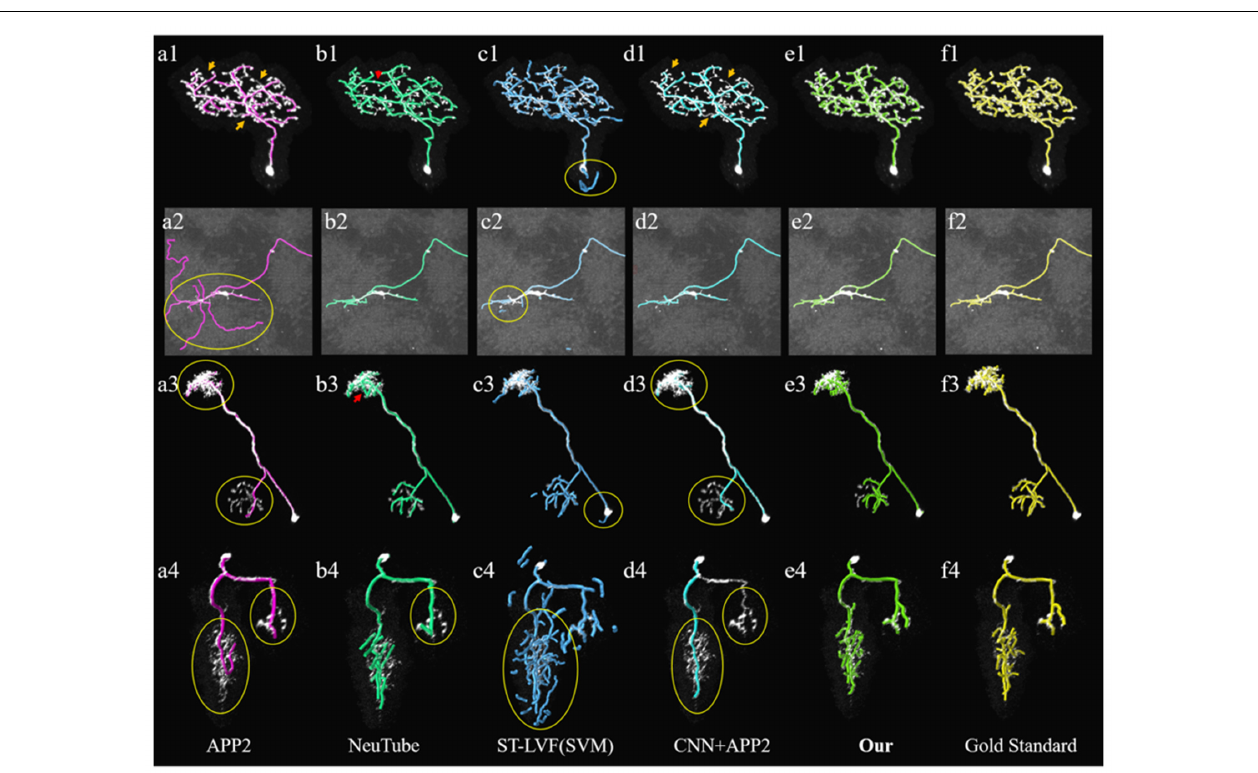
TABLE 1 | Quantitative evaluation of the proposed and state-of-art methods on public BigNeuron datasets. Method Precision [%]